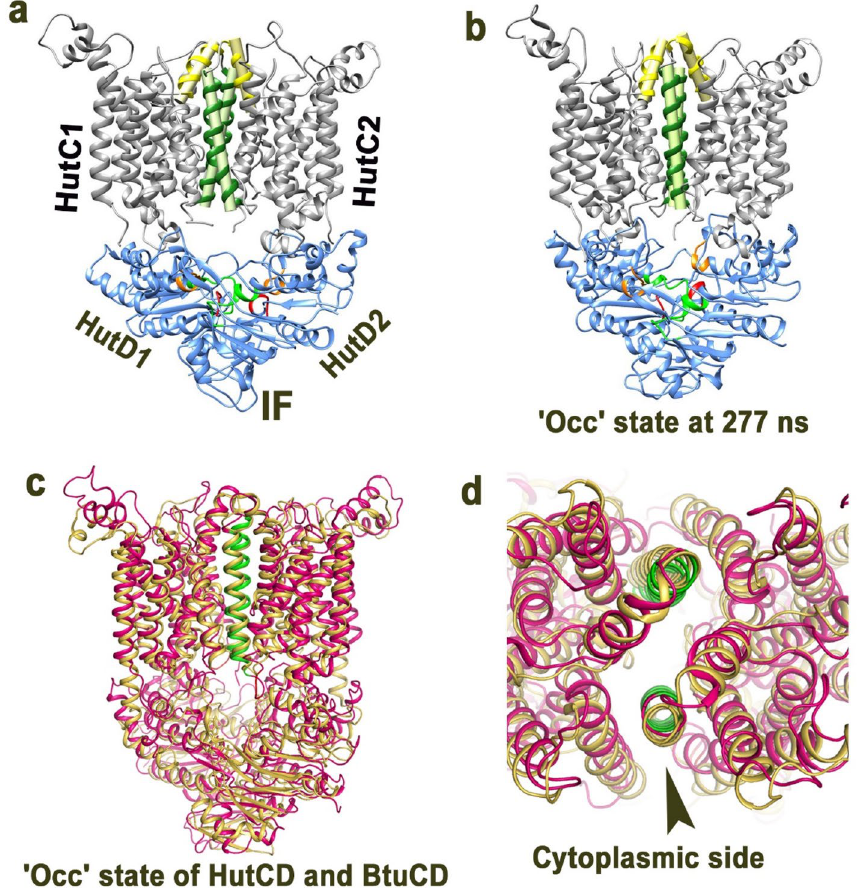
Figure 7. IF state of HutCD culminated to occluded state. ( a ) Ribbon representation of HutCD-IF model at 1 ns, showing axes of H5A (yellow), and TM5 (green), of each TMD in HutC dimer. ( b ) HutCD IF turned to ‘occluded’ state, snapshot taken at 277 ns from the unbiased MD study. Both in ( a,b ), D-loop, Walker-A and ‘ABC signature motif’ of HutD are shown in red, green and orange respectively. ( c ) Superposition of the ‘occluded’ state snapshot of HutCD IF at 277 ns on the ‘occluded’ state crystal structure of BtuCD (PDB code: 4FI3) ( d ) Zoomed view of ( c ) from cytoplasmic side showing similar orientation of TM5 helices (shown in green in case of